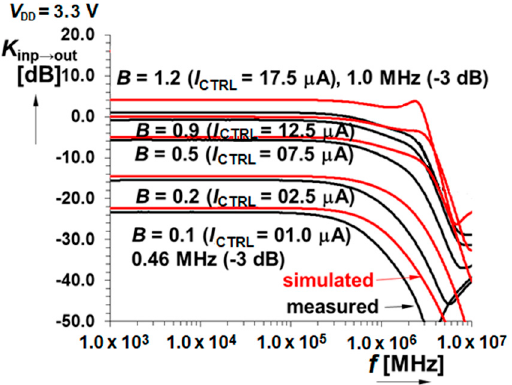
( b ) Figure 12. Simulated DFT analysis of the signal transferred from the gain control input; ( a ) Output current transient for I IN = 100 µA and the gain harmonically modified from 0 to 1; ( b ) DFT analysis expressed in dB related to the first harmonic component. 3.4. Frequency Response and Bandwidth